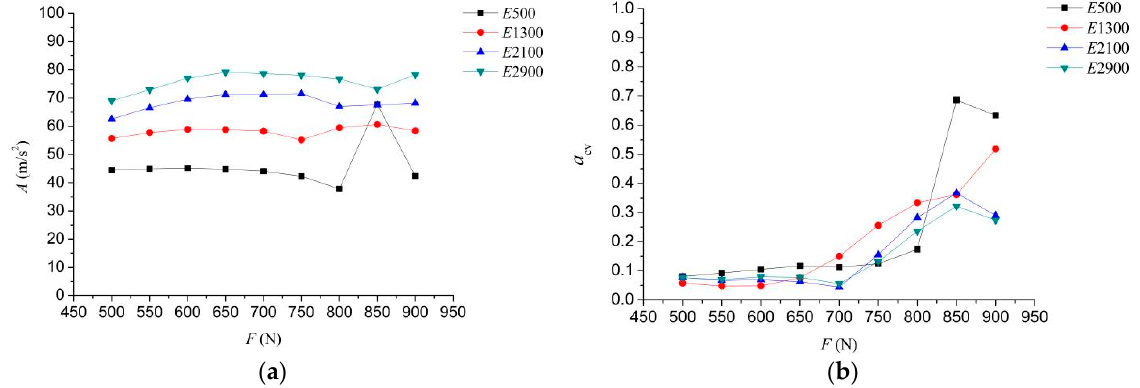
Figure 8. The curves of A and a cv changing with excitation force F. ( a ) The curve of A changing with excitation force F . ( b ) The curve of a cv changing with excitation force F .